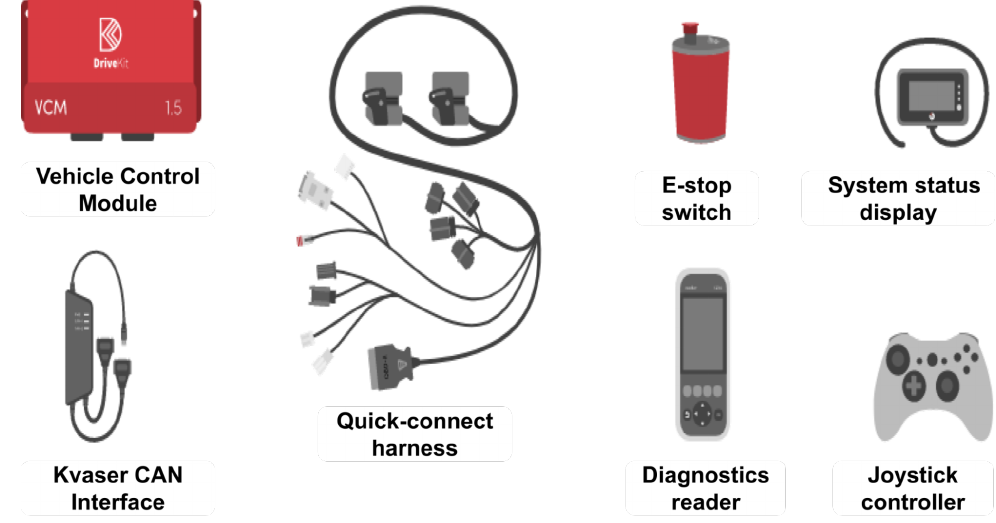
Figure 3. Polysync Drive-Kit with all of the components listed by name that are needed for